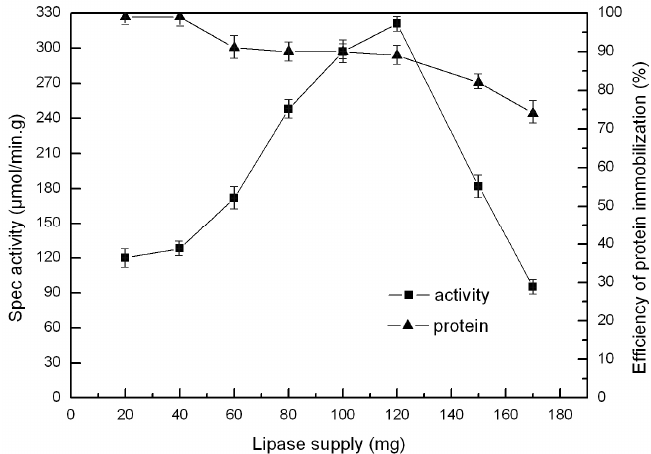
Figure 2. The effect of lipase supply. MTMS/TMOS molar ratio of 5:1, 60 mg of SiO 2 , water/silane molar ratio of 12, 120 μ L of PEG400.